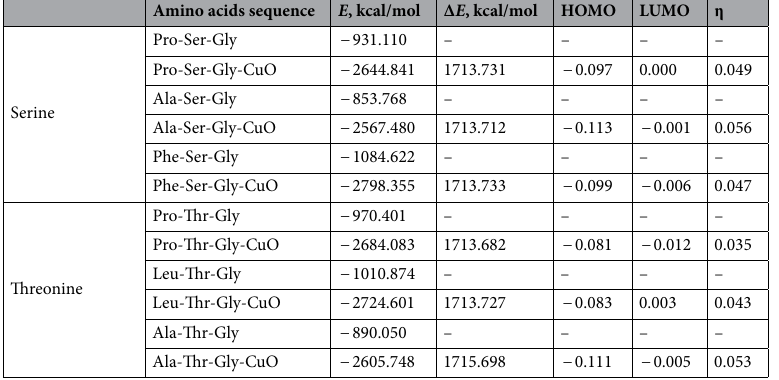
Table 2. Results of quantum-chemical simulation of the interaction of gelatin molecule sections with copper